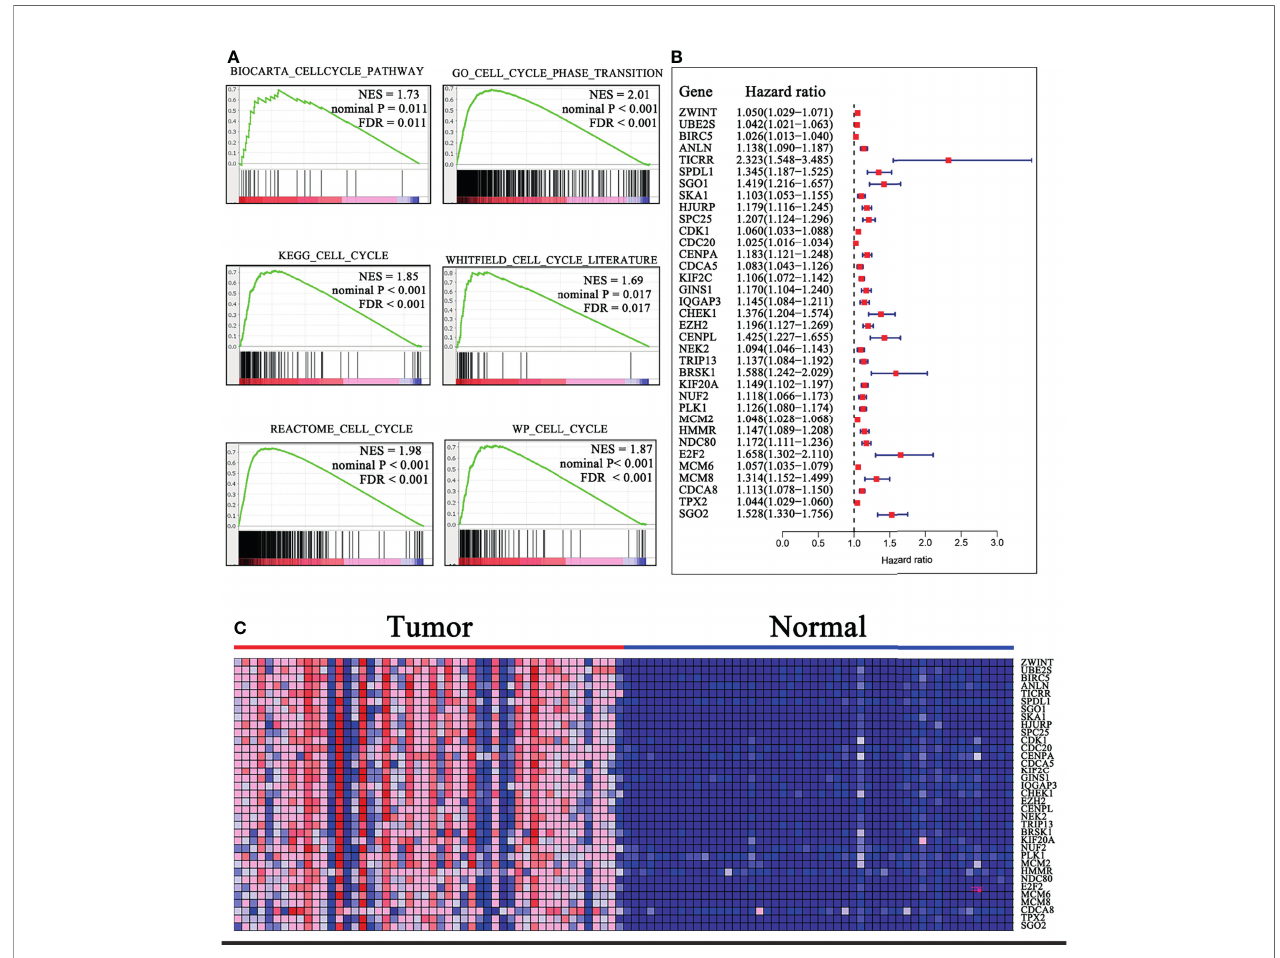
FIGURE 1 | Identi fi cation of the cell cycle-related genes. (A) Six gene sets were identi fi ed to be signi fi cantly enriched in HCC samples with FDR <0.25, NES >1.65, and nominal P < 0.02. (B) Forrest plot of 35 genes related to OS by univariate Cox analysis in TCGA cohort. P < 0.001. (C) Heatmap of 35 OS-related gene expressions in 50 HCC samples relative to normal peritumoral tissues from TCGA cohort. Overexpressed genes are in shades of red, and downregulated genes are in shades of blue. FDR, False discovery rate; NES, Normalized enrichment score; OS, overall